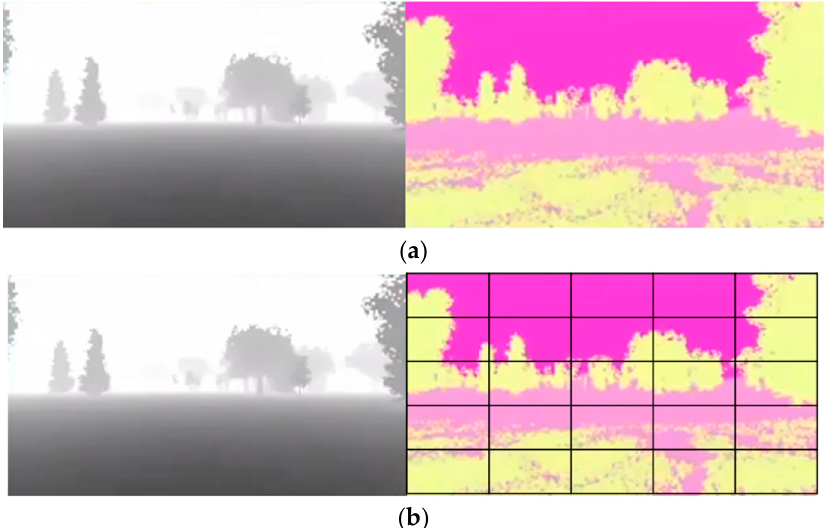
Figure 36. The depth image, divided into a 5 × 5 action space. ( a ) The original depth image. ( b ) The processed depth image.